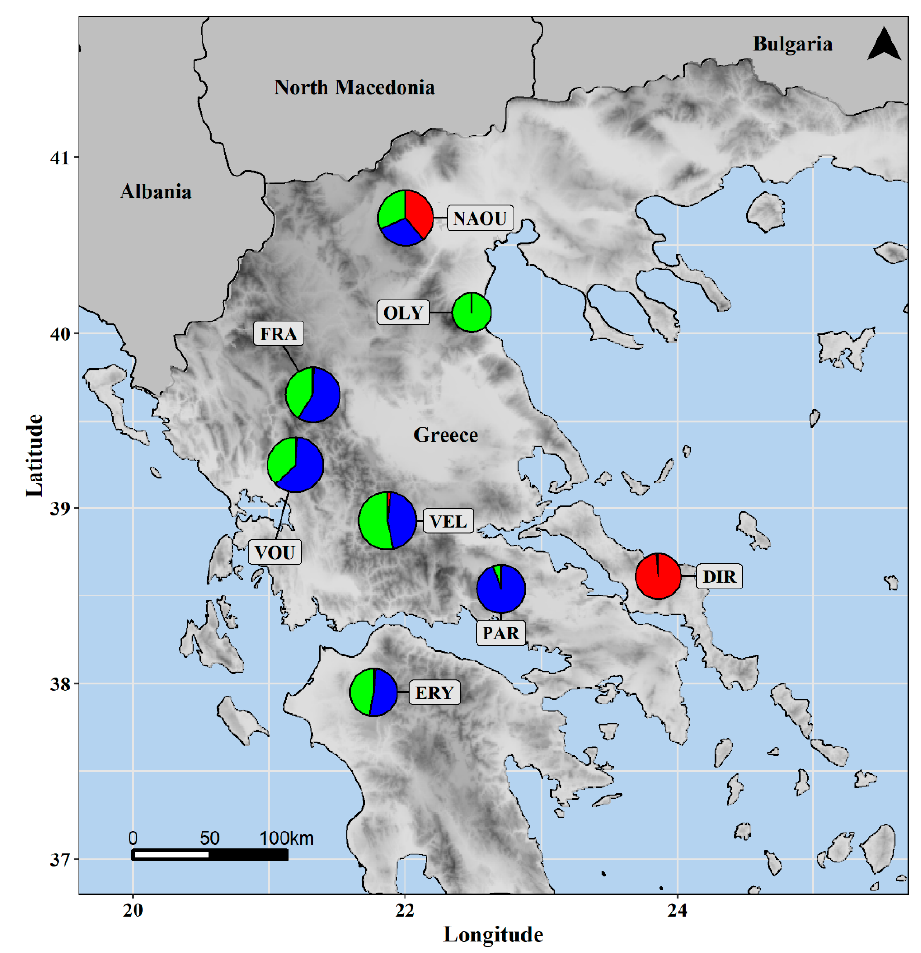
Figure 2. Genetic diversity and structure of eight populations of Helleborus odorus subsp. cyclophyllus from Greece. Genetic structure derived from Bayesian analysis using STRUCTURE at K = 3. The size of the dots is directly proportional to the depicted values of Nei’s gene diversity ( Hj ) for each population.